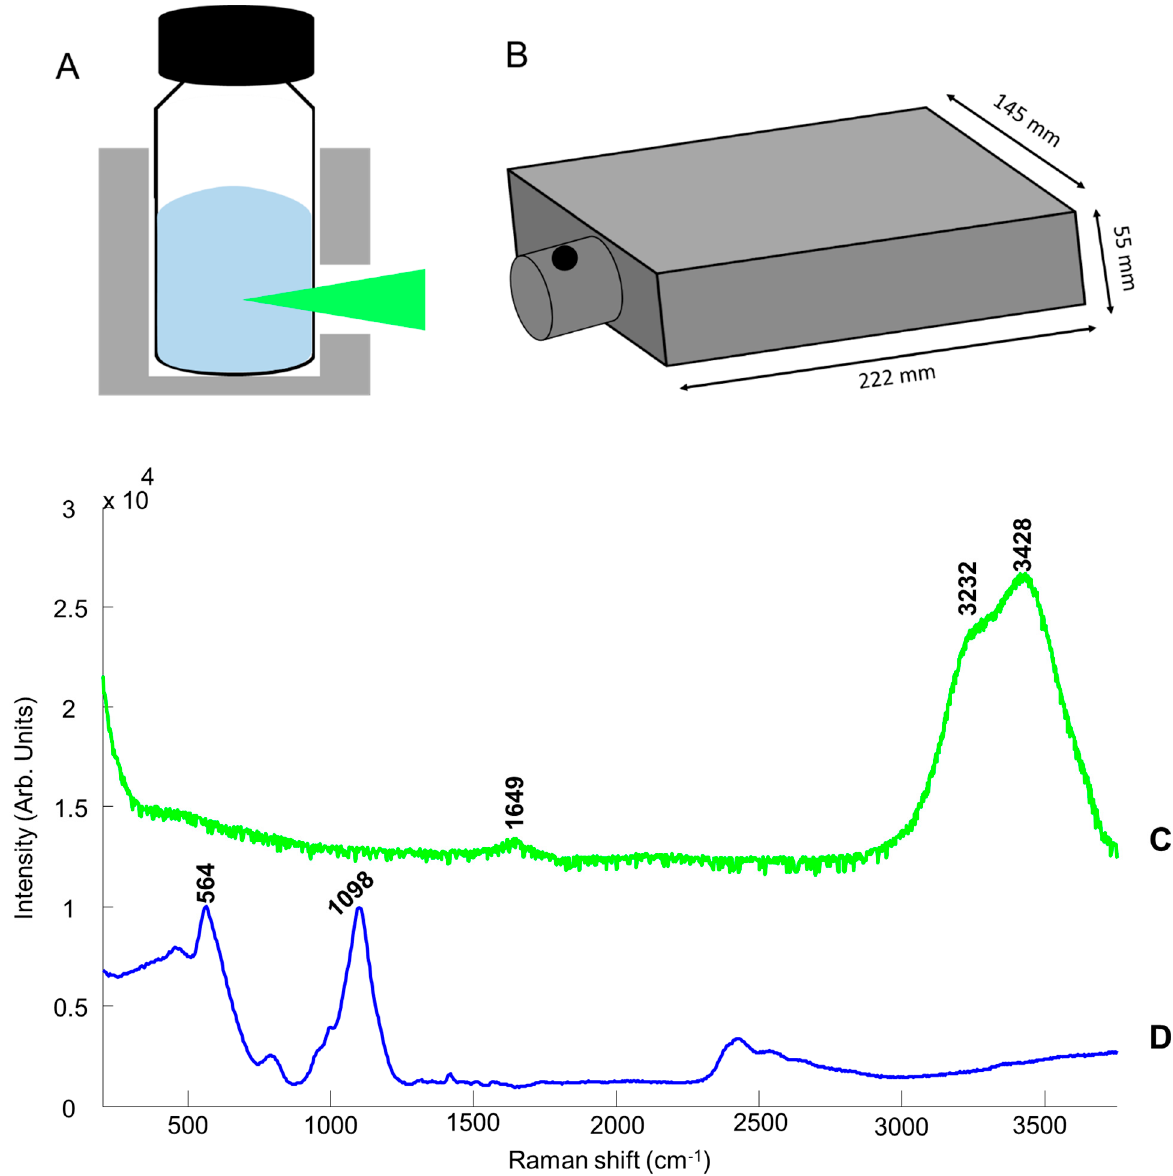
Figure 1. Illustration of the portable Raman device used: ( A ) sample holder, ( B ) the device, ( C ) mean Raman spectrum of the deionised water collected from a glass vial, and ( D ) a Raman spectrum of glass.